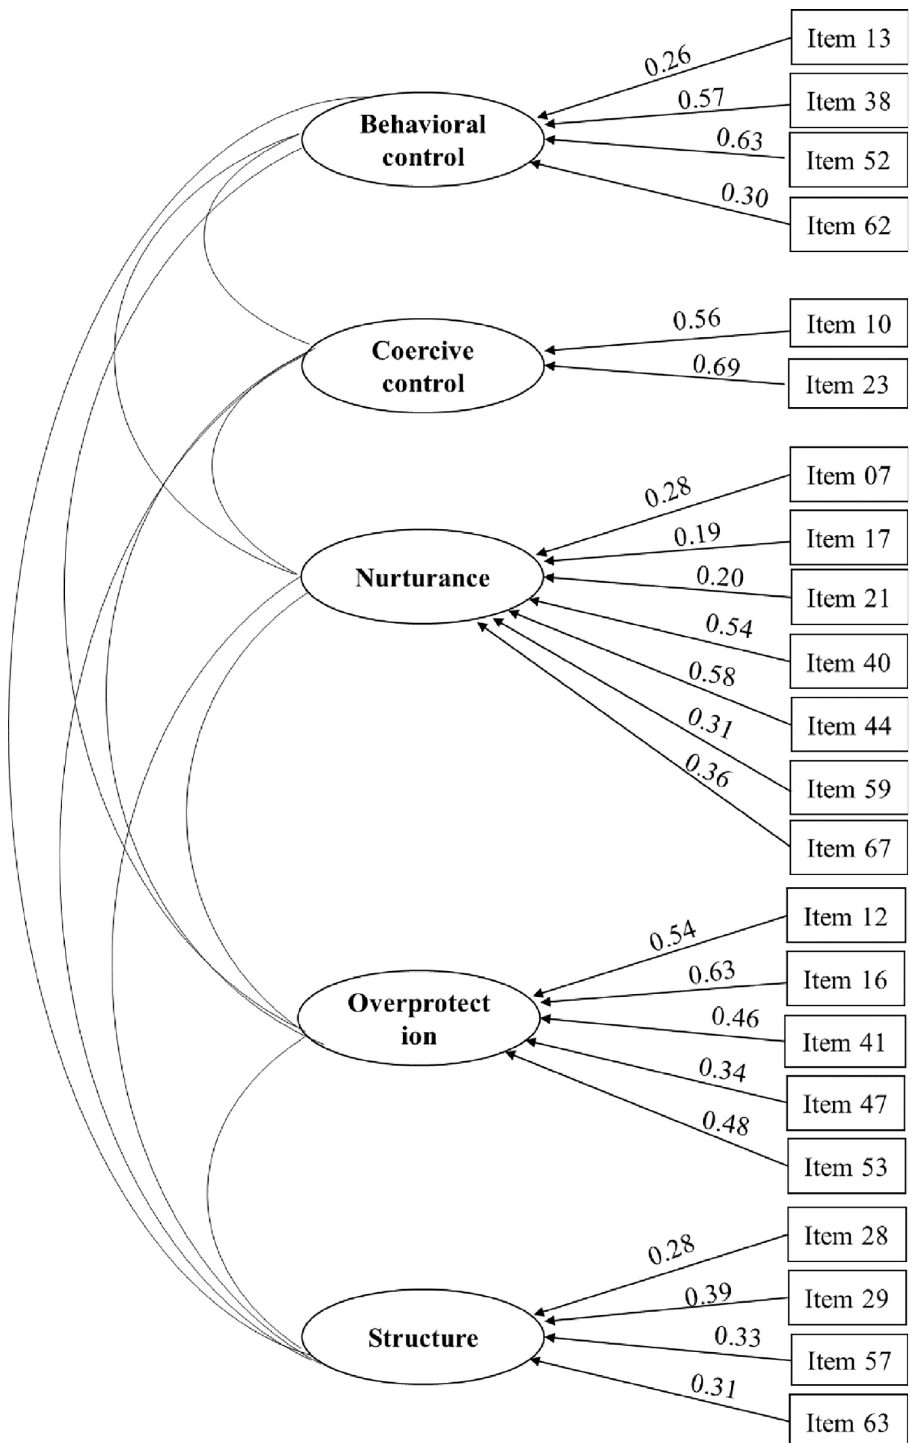
Fig 1. Standard estimation of Confirmatory Factor Analysis (CFA) for the 22 items (Study 2). All estimates p < 0.001.